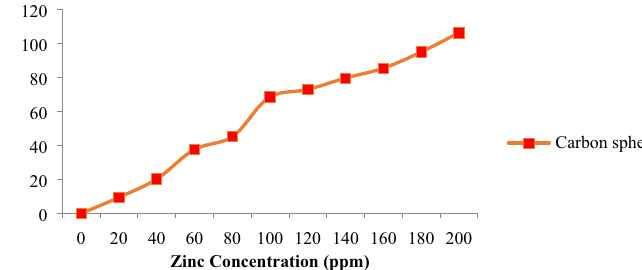
Figure 11. Zinc sorption pattern in carbon sphere.